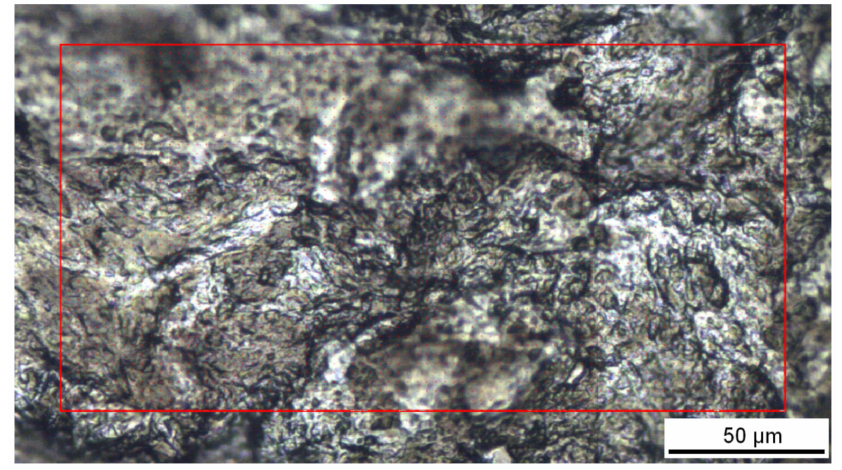
Figure 7. Optical image of carbon sample treated with excimer laser 4000 mJ · cm − 2